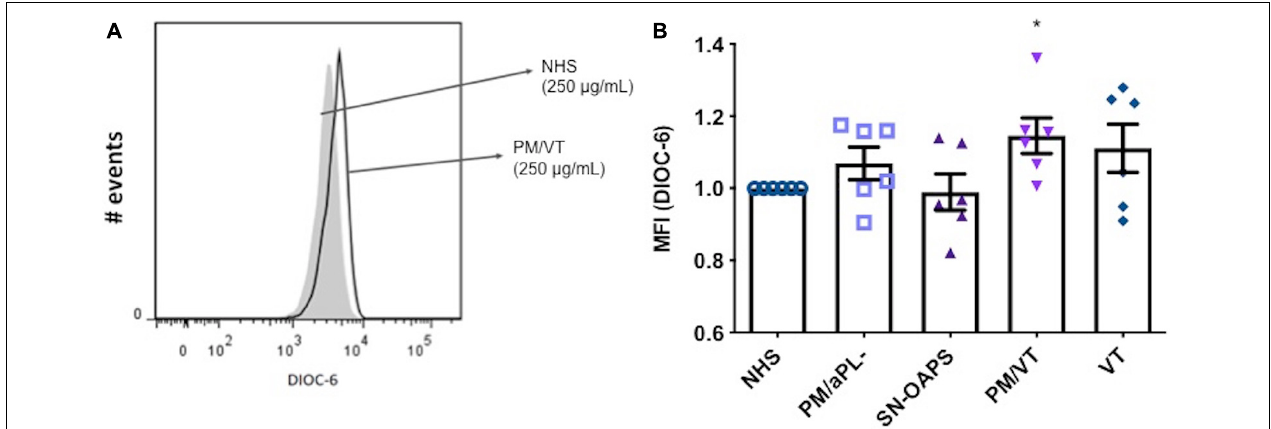
FIGURE 1 | Mitochondrial membrane potential (MMP) of endothelial cells is increased by antiphospholipid antibodies (aPL). Human umbilical vein endothelial cells (HUVECs) were stimulated with polyclonal immunoglobulin G (IgG) (250 µ g/ml) from women with clinical features of antiphospholipid syndrome (APS) [seronegative-obstetric APS (SN-OAPS); pregnancy morbidity and vascular thrombosis (PM/VT); and VT] and control groups [normal human serum (NHS) and PM/aPL-]. MMP was measured by 3,3 (cid:48) -dihexyloxacarbocyanine iodide (DiOC-6) incorporation and flow cytometric analysis. (A) Representative histogram showing HUVECs treated with NHS IgG and PM/VT IgG. (B) The chart shows that treatment of HUVECs with PM/VT IgG induced a significant increase in MMP in comparison with NHS IgG. n = 6; * p < 0.05 vs. NHS as determined by one-way ANOVA and Dunn’s post-test.